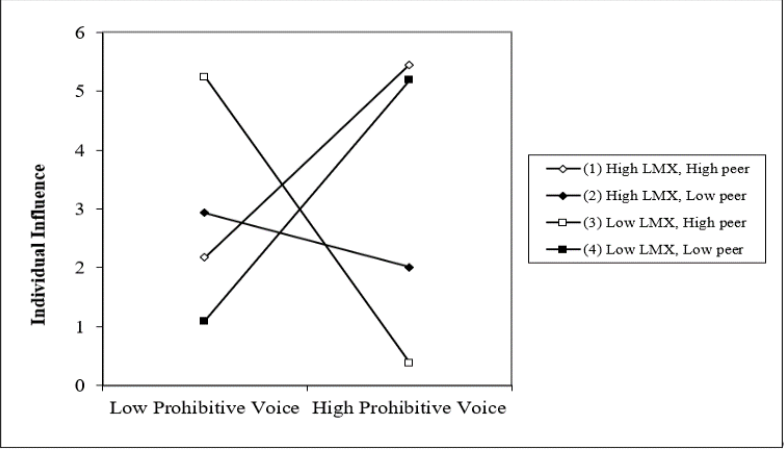
Figure 4. Three-way Interaction of LMX, Peer Relationship, and Prohibitive Voice.